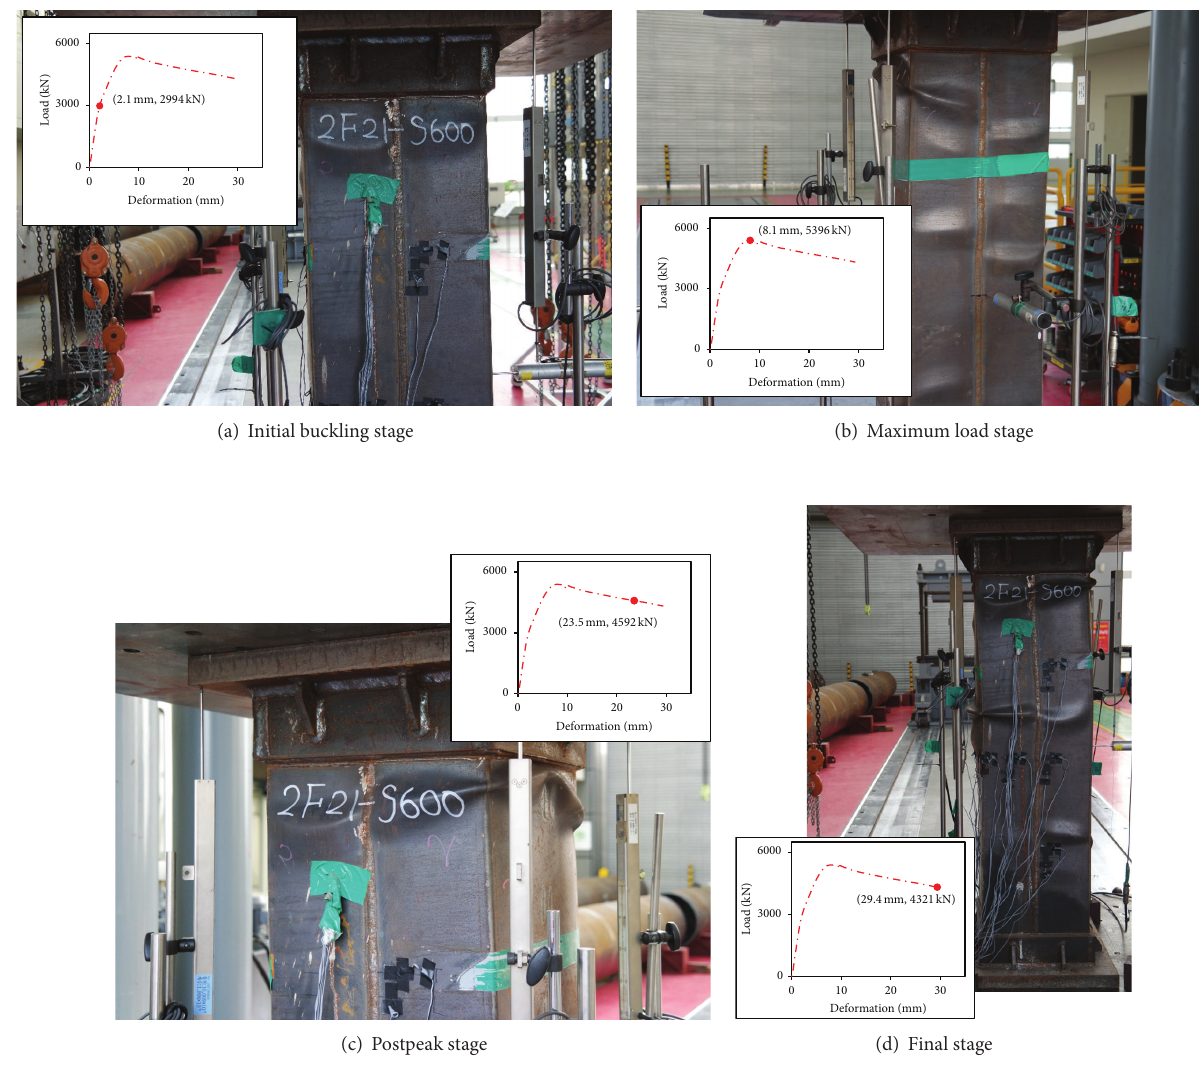
Figure 5: Detailed behavioral characteristics of P21-S600